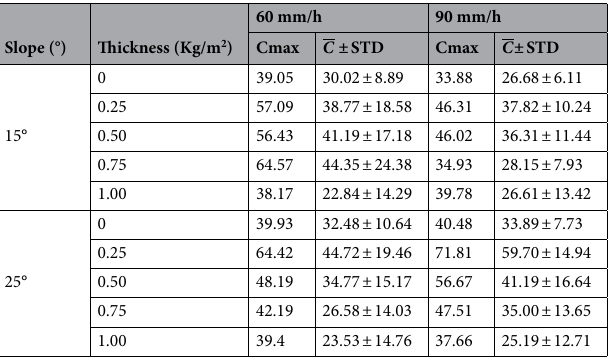
Table 3. Soil infiltration rate C max of organic mulch for different rainfall intensities (mm/min). C max indicates maximum infiltration rate, and C , STD indicates standard deviation of average infiltration rate for the different experimental